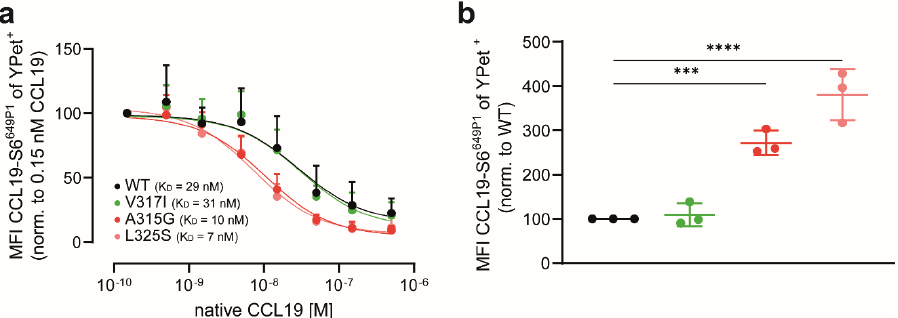
Figure 5. CCL19 binds with higher affinities to CCR7 dimerisation-defective mutants: ( a ) competition CCL19-S6 649P1 binding to CCR7 variants. HeLa cells were transiently transfected with YPet-tagged CCR7 variants and incubated with 25 nM of fluorescently labelled CCL19-S6 649P1 in the presence or absence of graded concentrations of native, unlabelled CCL19. Cells were extensively washed and mean fluorescence intensities (MFIs) of CCL19-S6 649P1 bound to CCR7 variants were measured by flow cytometry; ( b ) maximal CCL19-S6 649P1 binding to CCR7 mutants normalised to CCR7 WT. ( a , b ) n = 3, mean ± SD, statistical analysis: one-way ANOVA. *** p < 0.01; **** p < 0.0001.